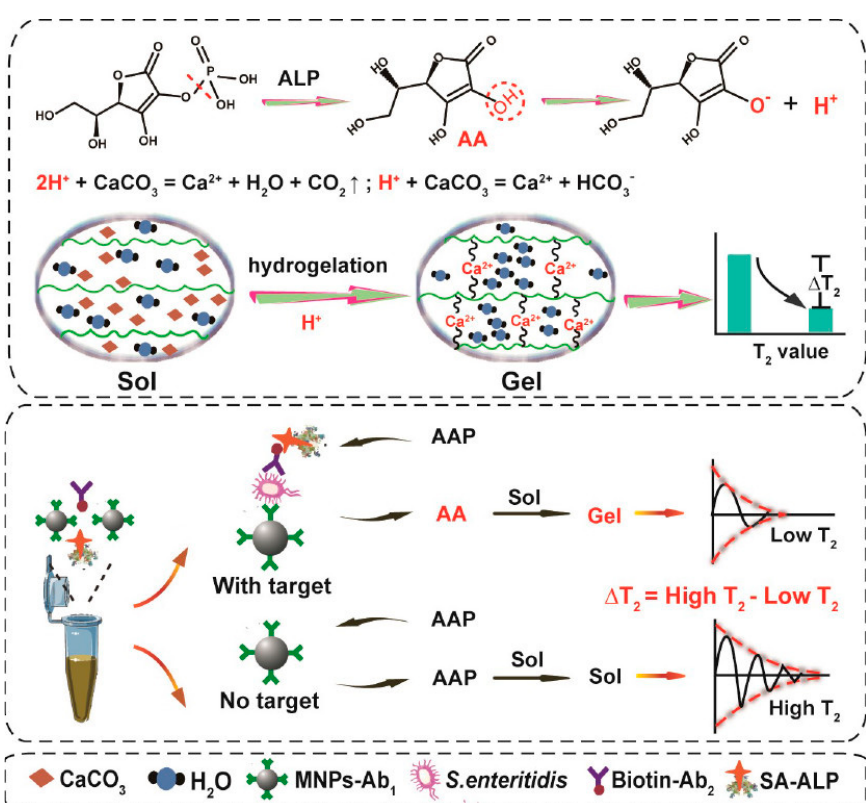
Figure 6. Schematic illustration of the hydrogelation of alginate hydrogels and T 2 biosensing strategy with the assistance of enzyme for the immunoassay of S. enteritidis. Reproduced with permission from Luyu Wei, Analytical Chemistry; published by the American Chemical Society, 2021.